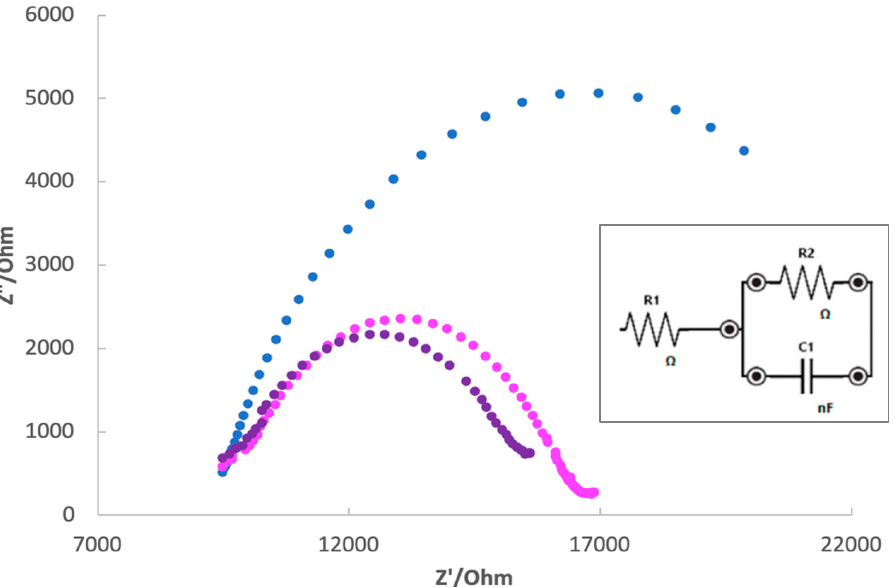
Figure 3. Nyquist plot of electrode modified with NIP (blue), washed MIP (purple) and MIP re-charged with MCPA 10 − 7 mol L − 1 (pink). Measurements were performed in 5 mmol L − 1 K 4 Fe(CN) 6 /0.1 mol L − 1 KCl at pH 7.2. The insert in the figure is the Randles equivalent circuit of the trends reported in the Nyquist plot for all three modified electrodes.